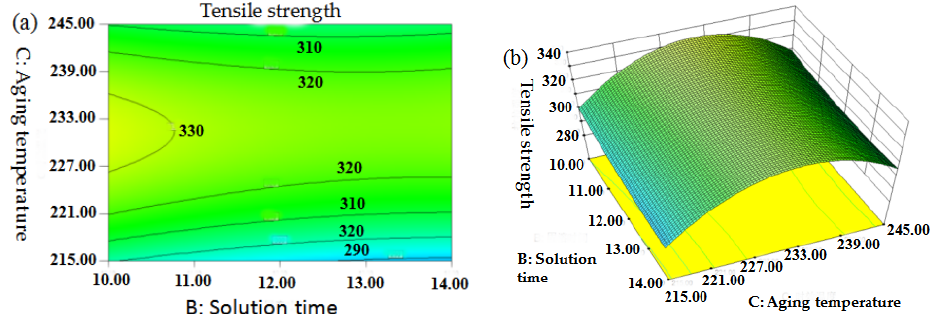
Figure 13. Interaction between ageing temperature and solution time versus the tensile strength. ( a ) contour map; ( b ) surface response map.